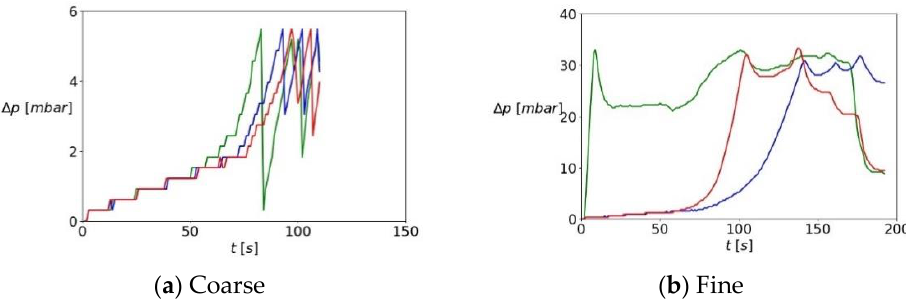
Figure 8. Measurements of the pressure evolution during the bubble point test of two wire mesh screens ( a ) coarse and ( b ) fine. The measurements are taken four times for each mesh.